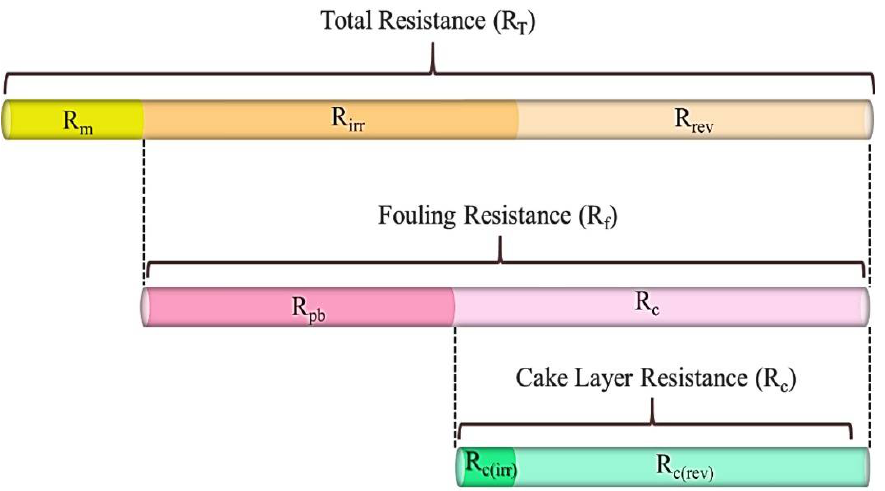
Figure 2. The role of fouling mechanisms in a membrane bioreactor. Modified from Di Bella et al. by specifying the two types of cake layer resistances [24].